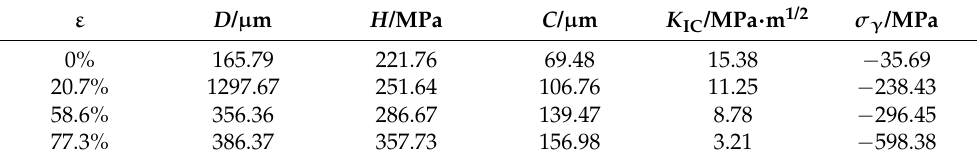
Table 8. Mechanical properties of the near-pit regions on Cu strip surfaces with different reductions.